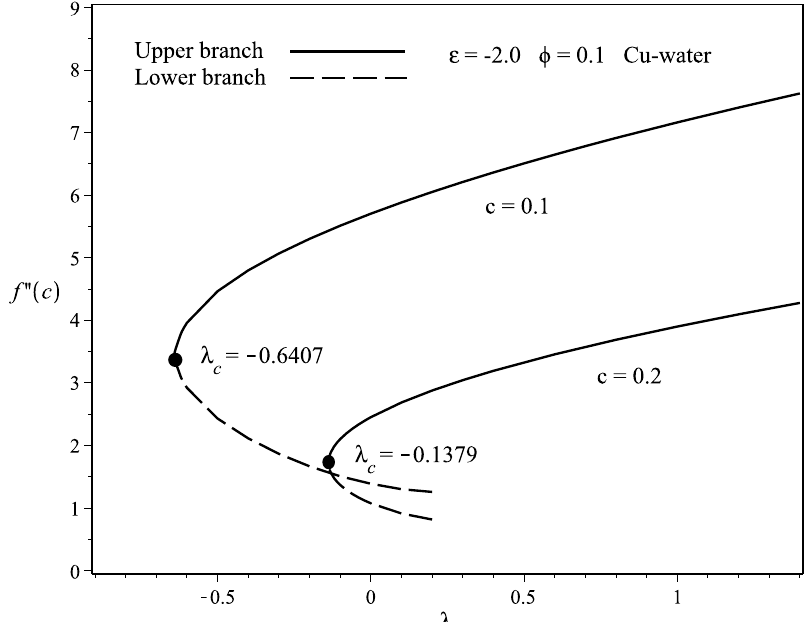
Figure 6. Effect of mixed convection parameter λ on the variation of shear stress for different needle sizes c .